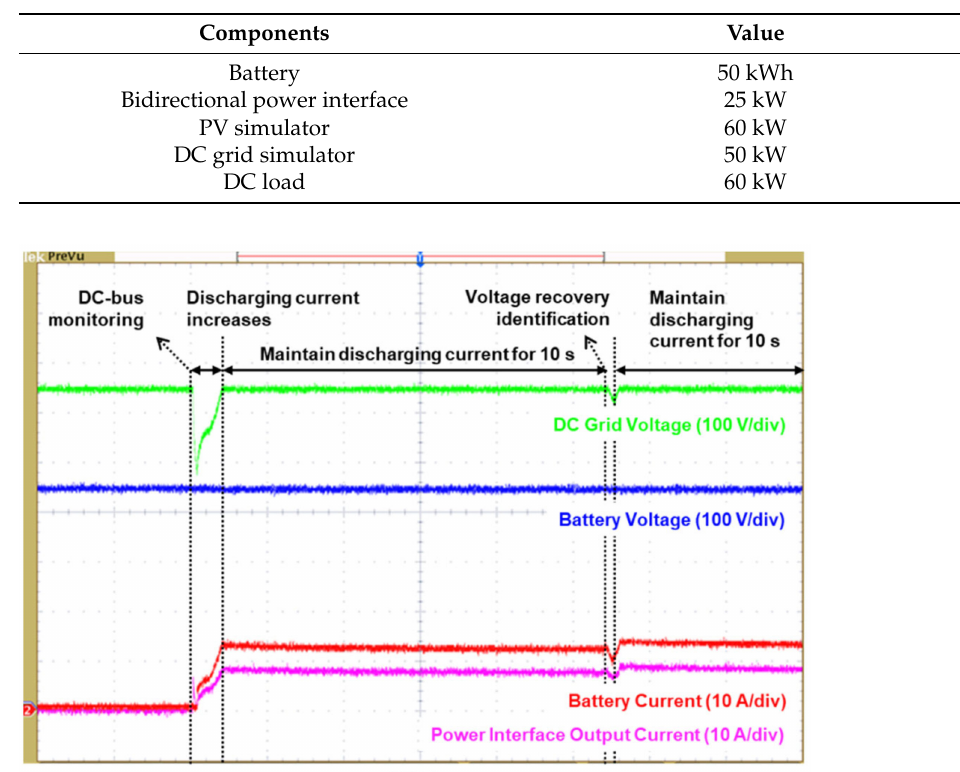
Figure 13. Experimental setup of lab-scale DC microgrid prototype. Table 1. Hardware configurations of lab-scale DC microgrid prototype.